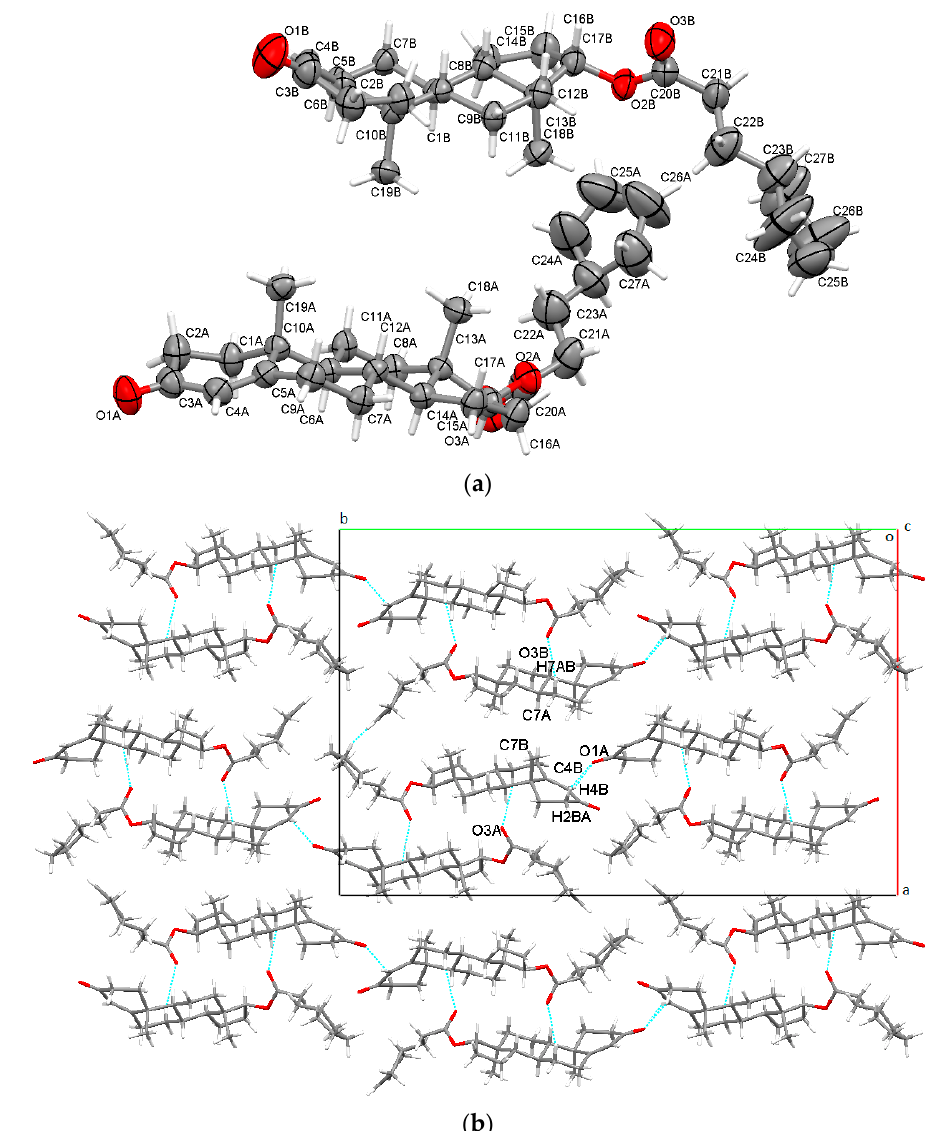
Figure 3. Asymmetric unit of TCyp presenting non-hydrogen atoms at 50% probability level ( a ); overall packing viewed along c-axis ( b ) .